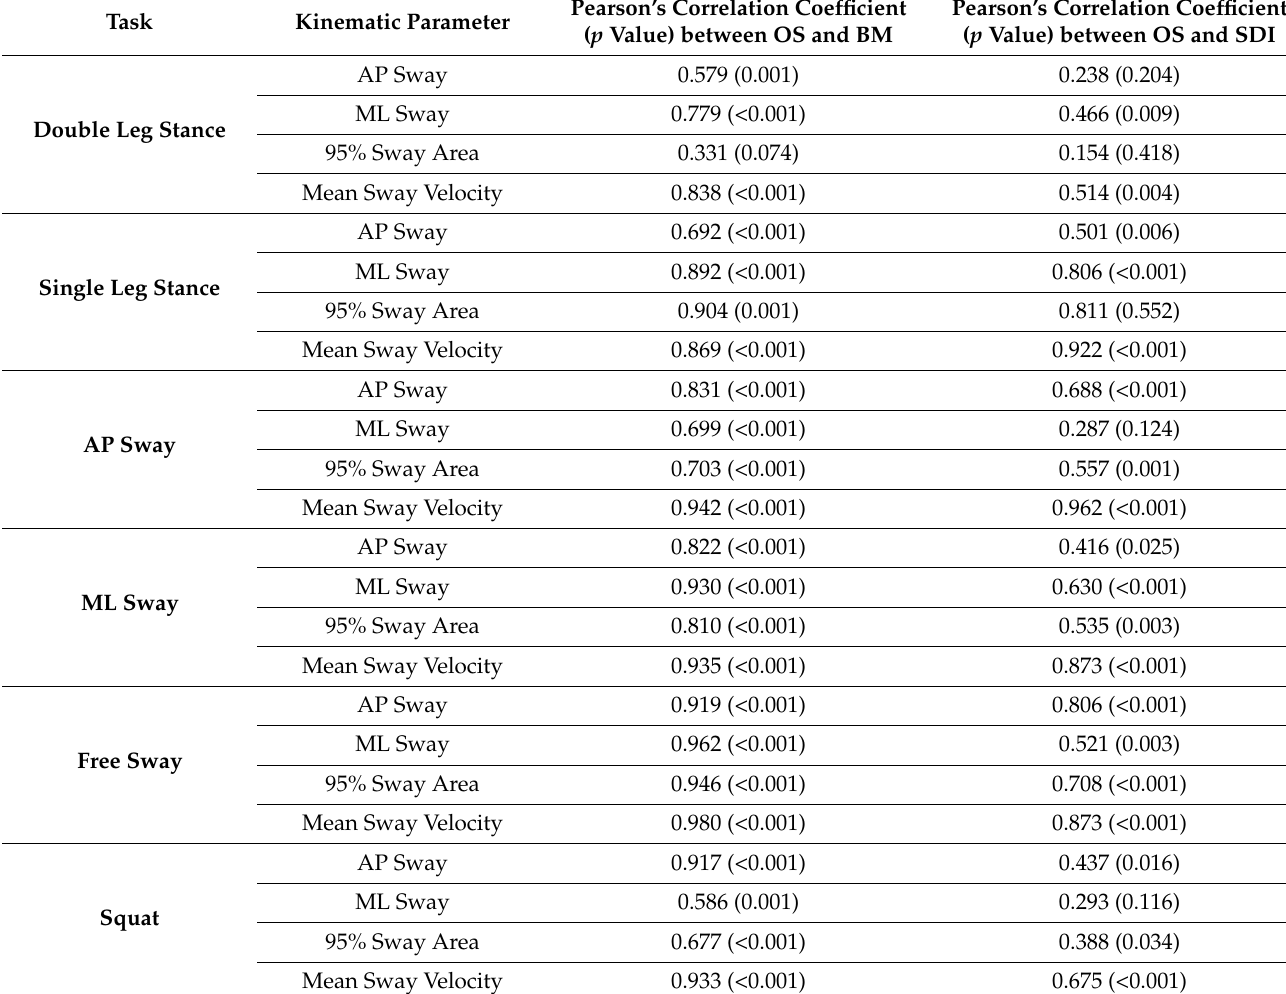
Table 2. Pearson’s correlation coefficients between the kinematic parameters computed using each method, based on inertial sensors (Biomechanical Model based on an Inertial Sensors Network, BM, and Strapdown Integration, SDI) and the optoelectronic system (OS). AP—anteroposterior, ML—mediolateral. Pearson’s correlation coefficient interpretation: 0.0–0.2 very weak correlation; 0.2–0.4 weak correlation; 0.4–0.7 moderate correlation; 0.7–1.0 strong